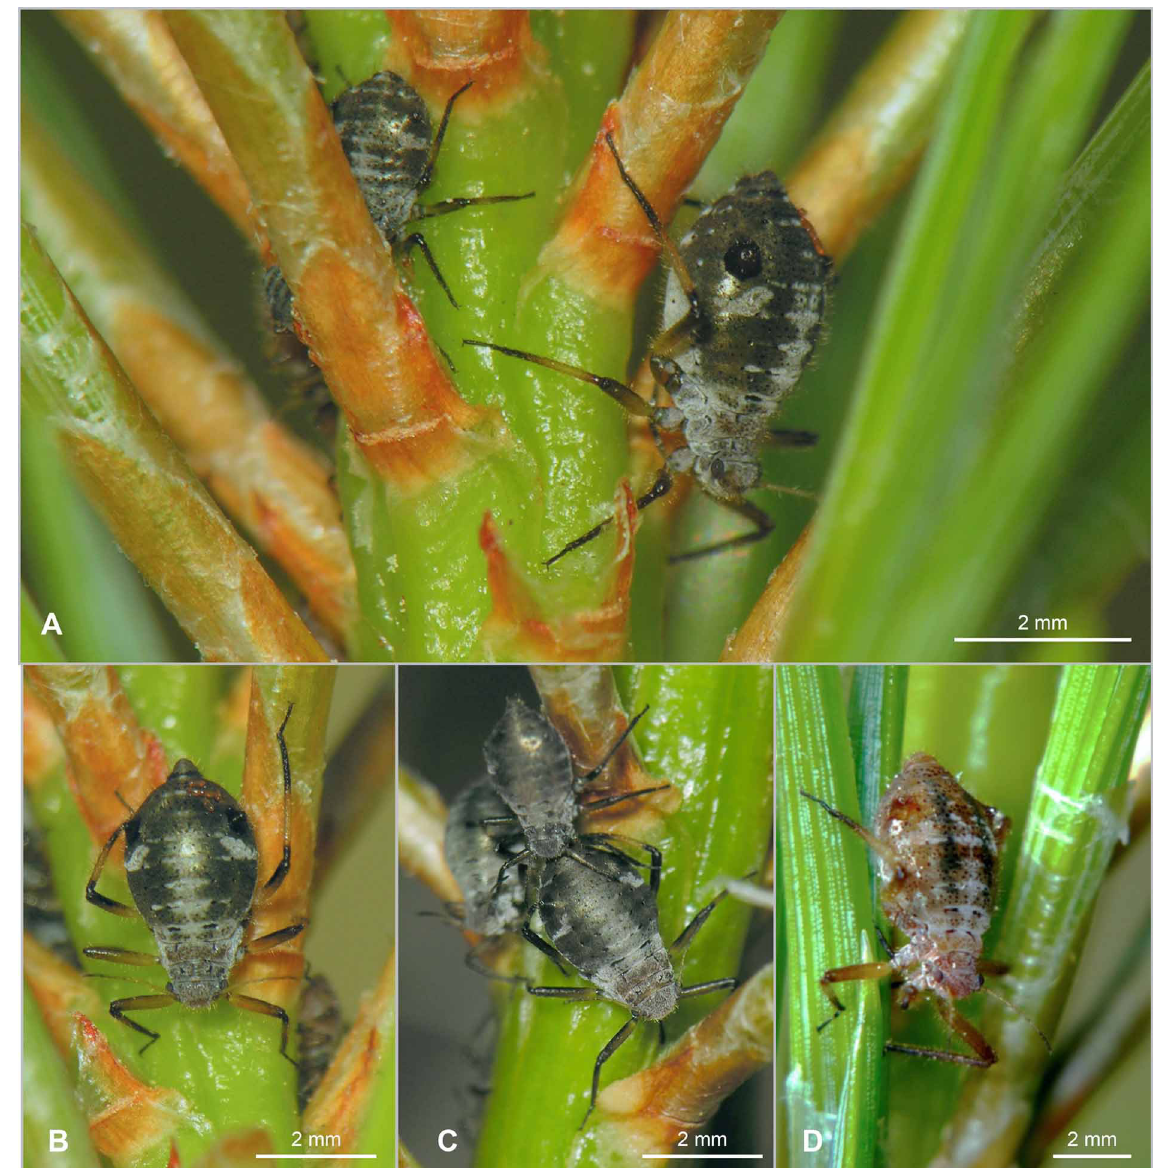
Fig. 101. Cinara (Cinara) pinea (Mordvilko, 1895). Apterae and juveniles on young shoots of Pinus sylvestris